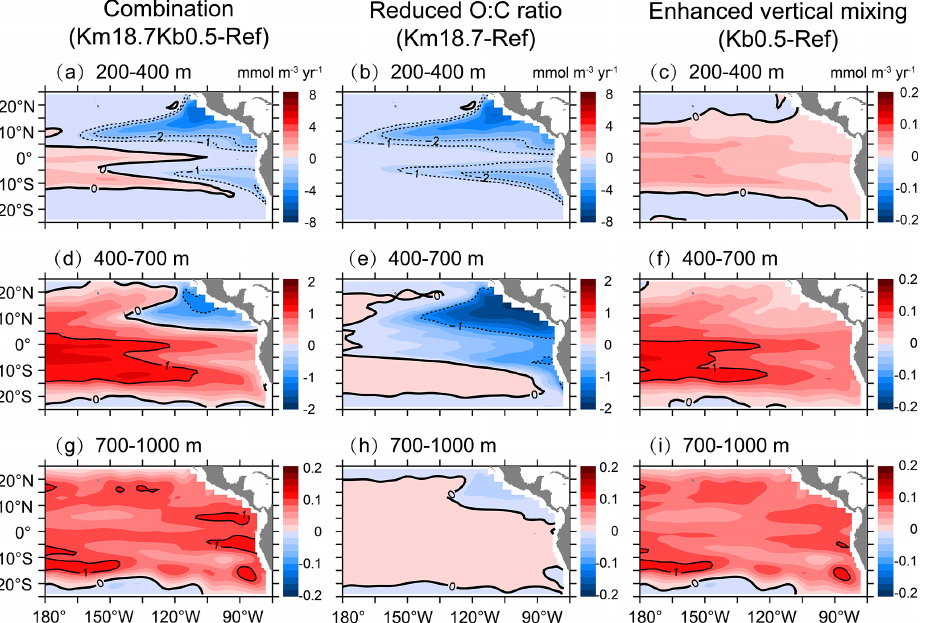
Figure 9. Changes in physical supply over (a, b, c) 200–400m, (d, e, f) 400–700m, and (g, h, i) 700–1000m due to the combination of a reduced O : C utilization ratio and an enhanced vertical mixing ( a, d, g ), a reduced O : C utilization ratio ( b, e, h ), and an enhanced vertical mixing ( c, f, i ).